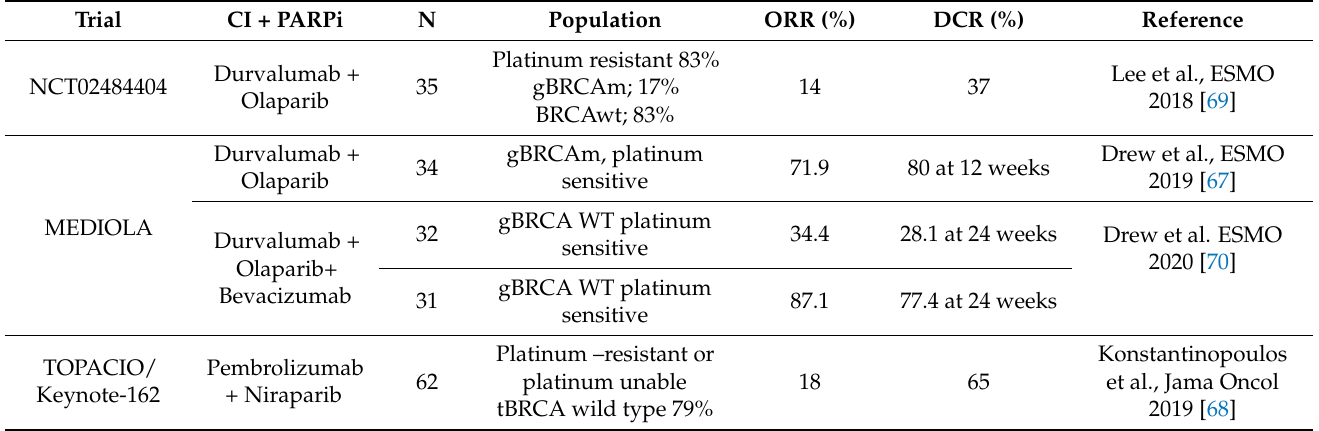
Table 2. Completed clinical studies including polytherapy in patients with ovarian